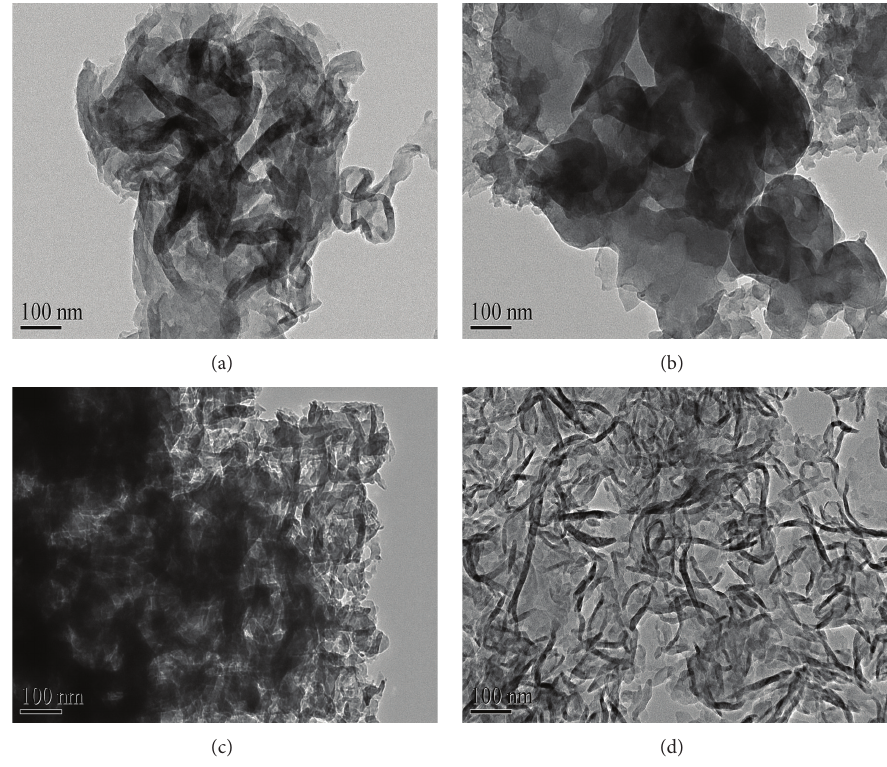
Figure 3: TEM images of CN-T (a), CN-D (b), CN-M (c), and CN-U